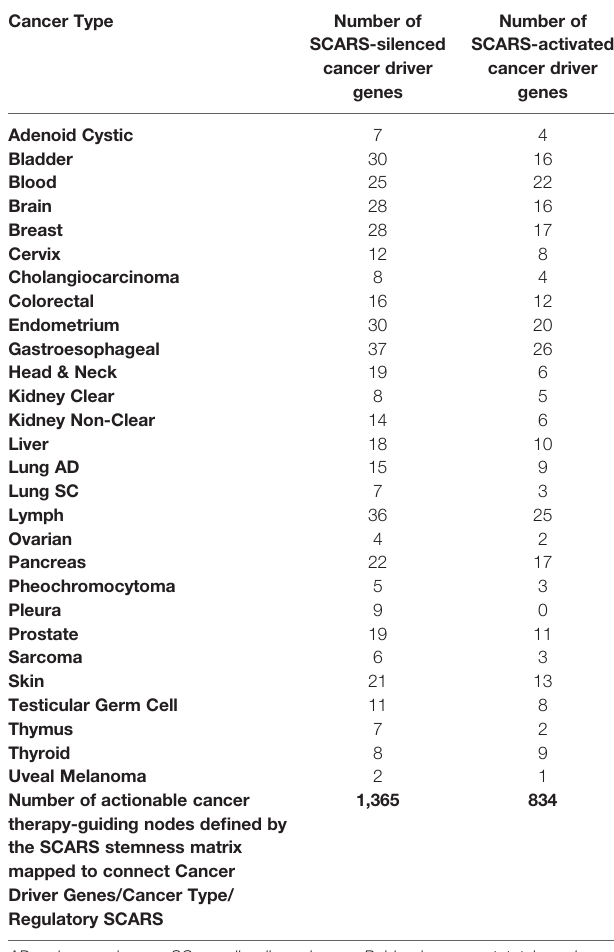
TABLE 5 | SCARS-guided cancer stemness matrix of diagnostic and therapeutic targets comprising of 237 SCARS-down-regulated and 141 SCARS- activated cancer driver genes mapped to 28 cancer